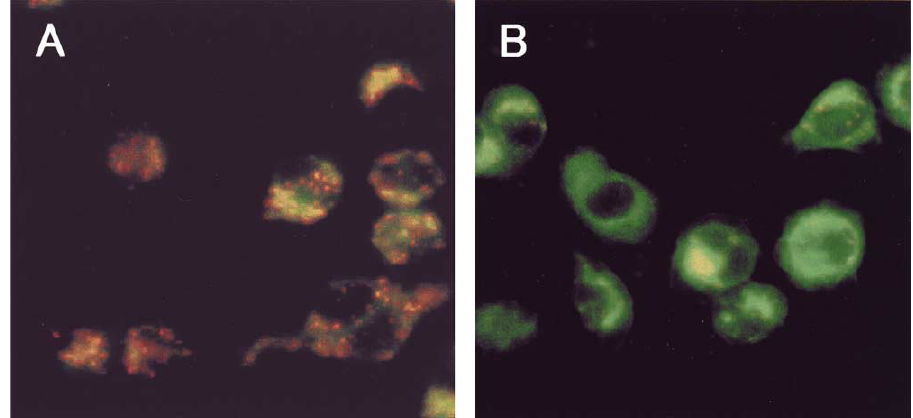
FIG. 7. Analysis of mitochondorial membrane potential of the BAC1.2F5 cells cultured with securioside B. The cells were cultured without (A) or with (B) 10 m g/ml securioside B in the presence of L-cell-conditioned medium (20%). On day 2, the cells were stained with DePsipher. The intact mitochondria appear red, whereas mitochondria with disrupted potential appear green.